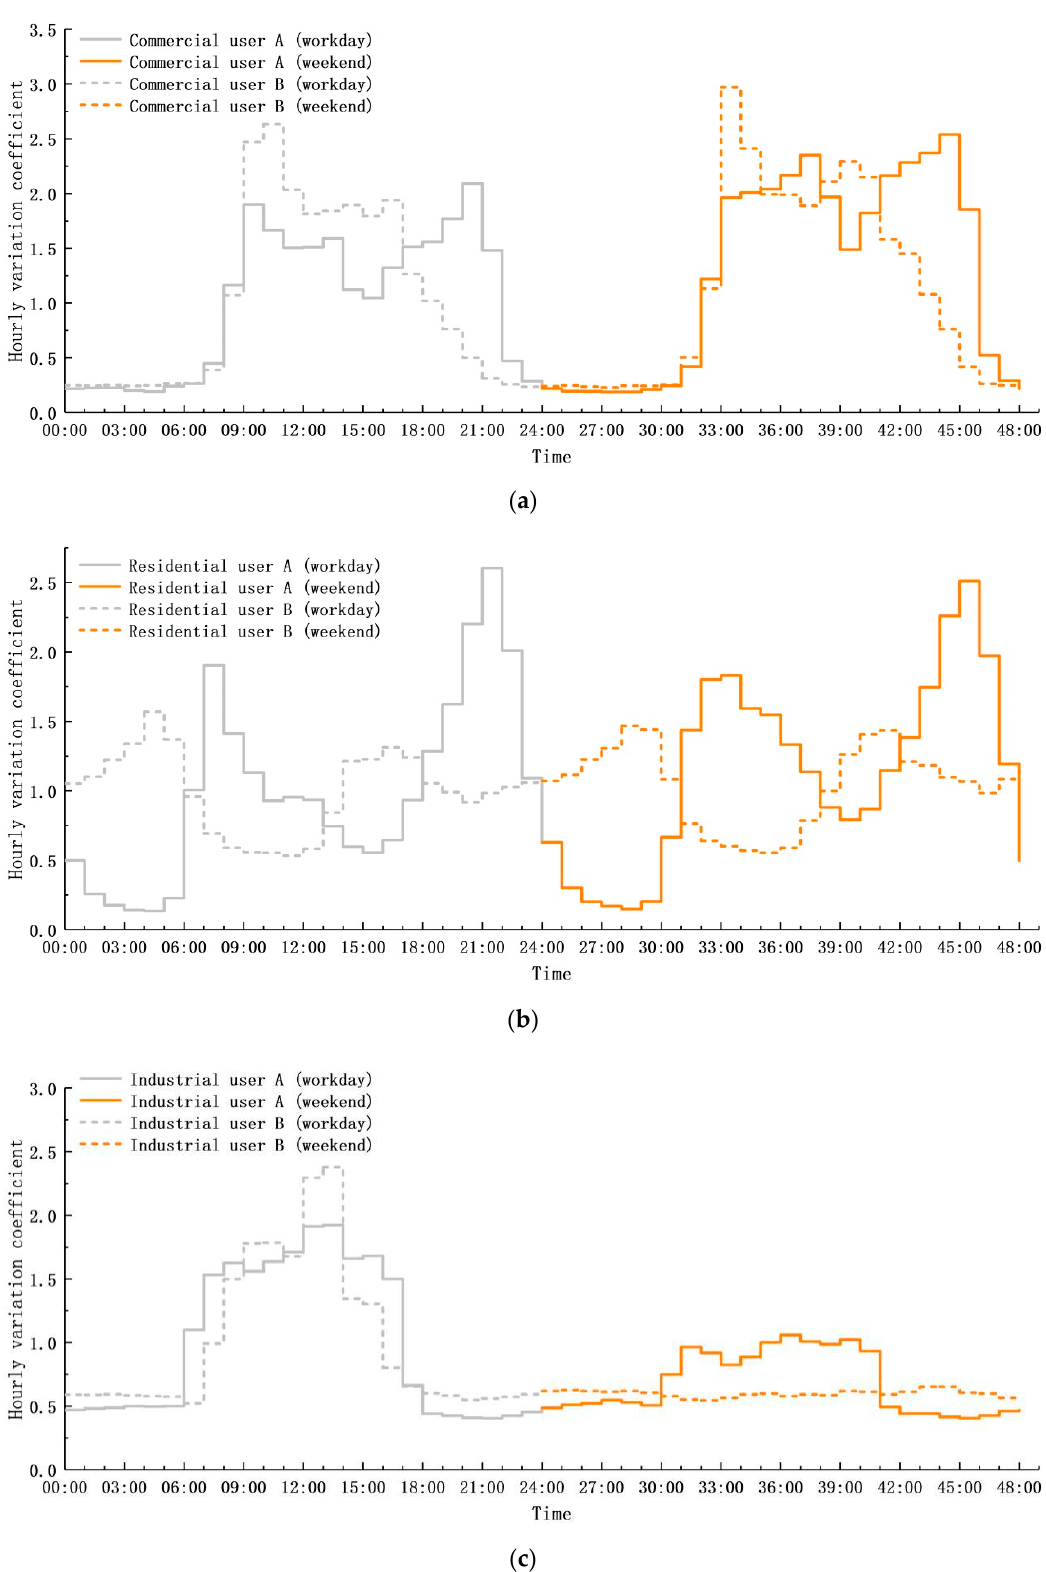
Figure 7. Demand patterns of users of the same type: ( a ) two commercial users; ( b ) two residential users; ( c ) two industrial users.